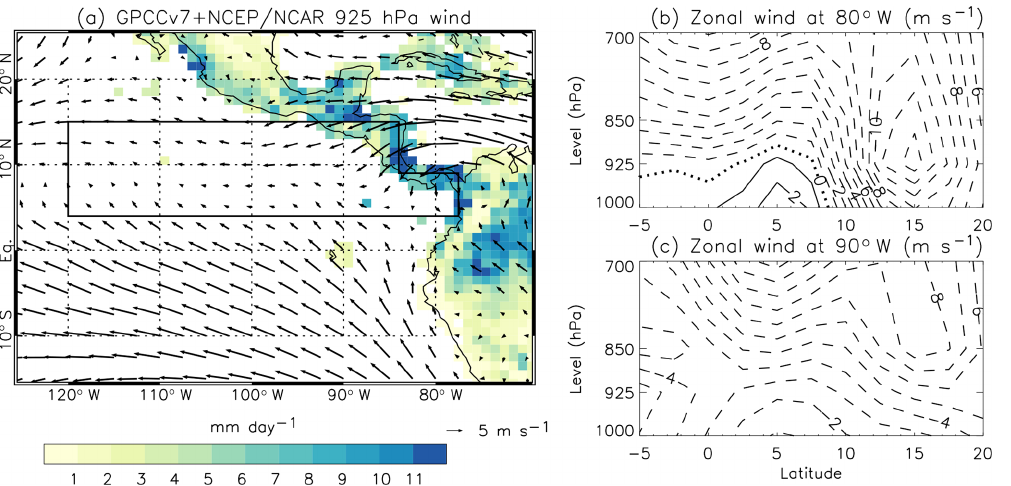
Figure 2. (a) NCEP-NCAR wind vector at 925hPa for August 1997. The black box indicates the area where the index developed in this paper is defined. (b) Cross section of the zonal wind from 5 ◦ S to 20 ◦ N at 80 ◦ W. (c) Cross section of the zonal wind from 5 ◦ S to 20 ◦ N at 90 ◦ W. In (b) and (c) , positive/negative (westerly/easterly) zonal wind is indicated by continuous/dashed